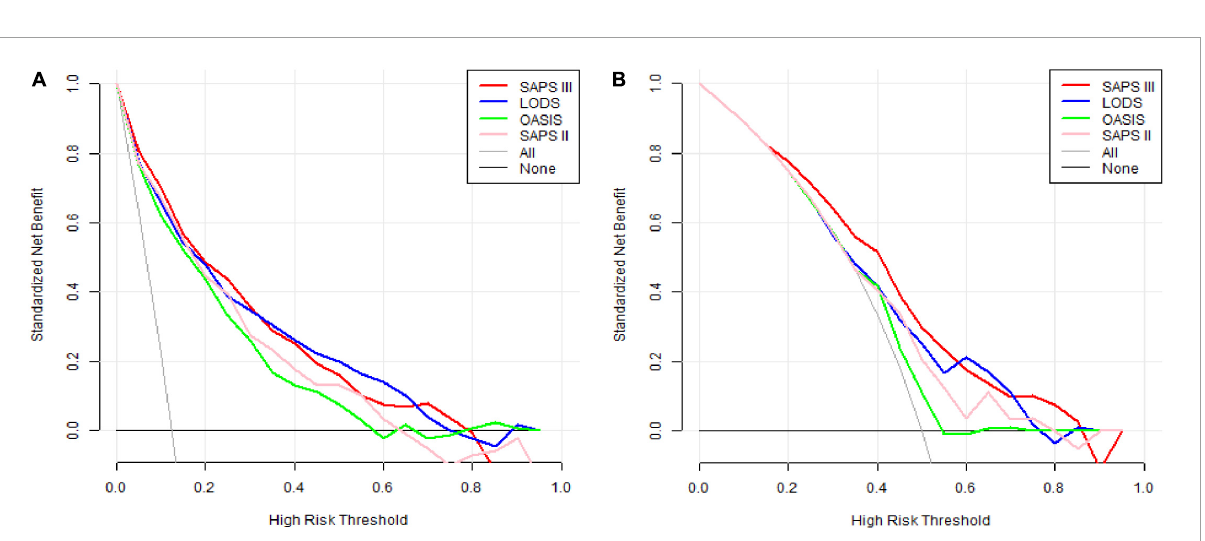
FIGURE4 (A) DCA curves of LODS, OASIS, SAPS II, and SAPS III before PSM. (B) DCA curves of LODS, OASIS, SAPS II, and SAPS III after PSM. DCA, decision curve analysis; LODS, logistic organ dysfunction system; OASIS, oxford acute severity of illness score; SAPS, simplified acute physiology score; PSM, propensity score